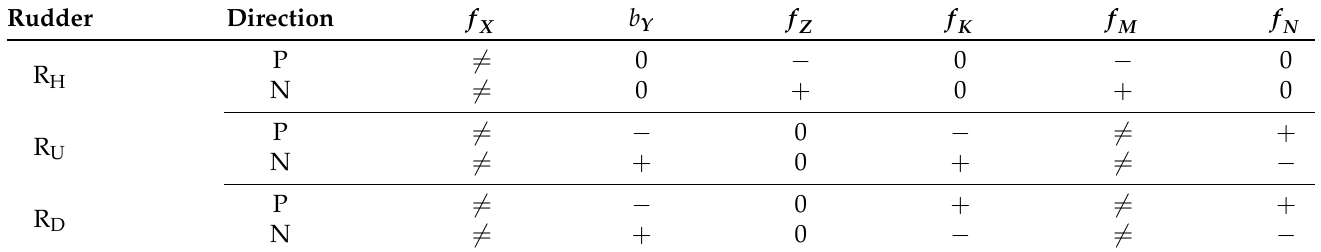
Table 1. Features of the faults from the rudder system inside the